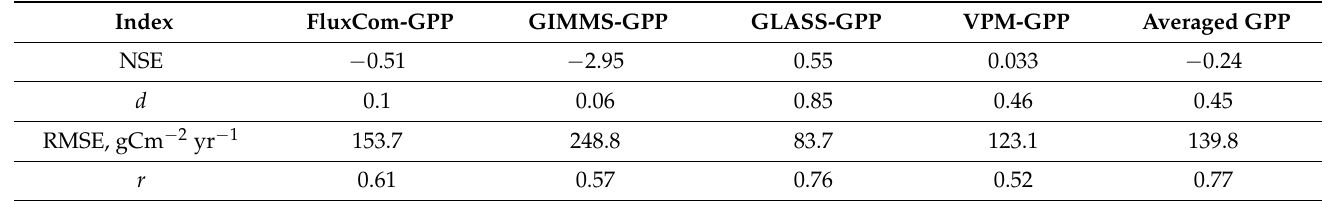
Table 2. Accuracy metrics summarizing the performance of the four GPP datasets against the observed GPP at the EC tower in Yatir forest.